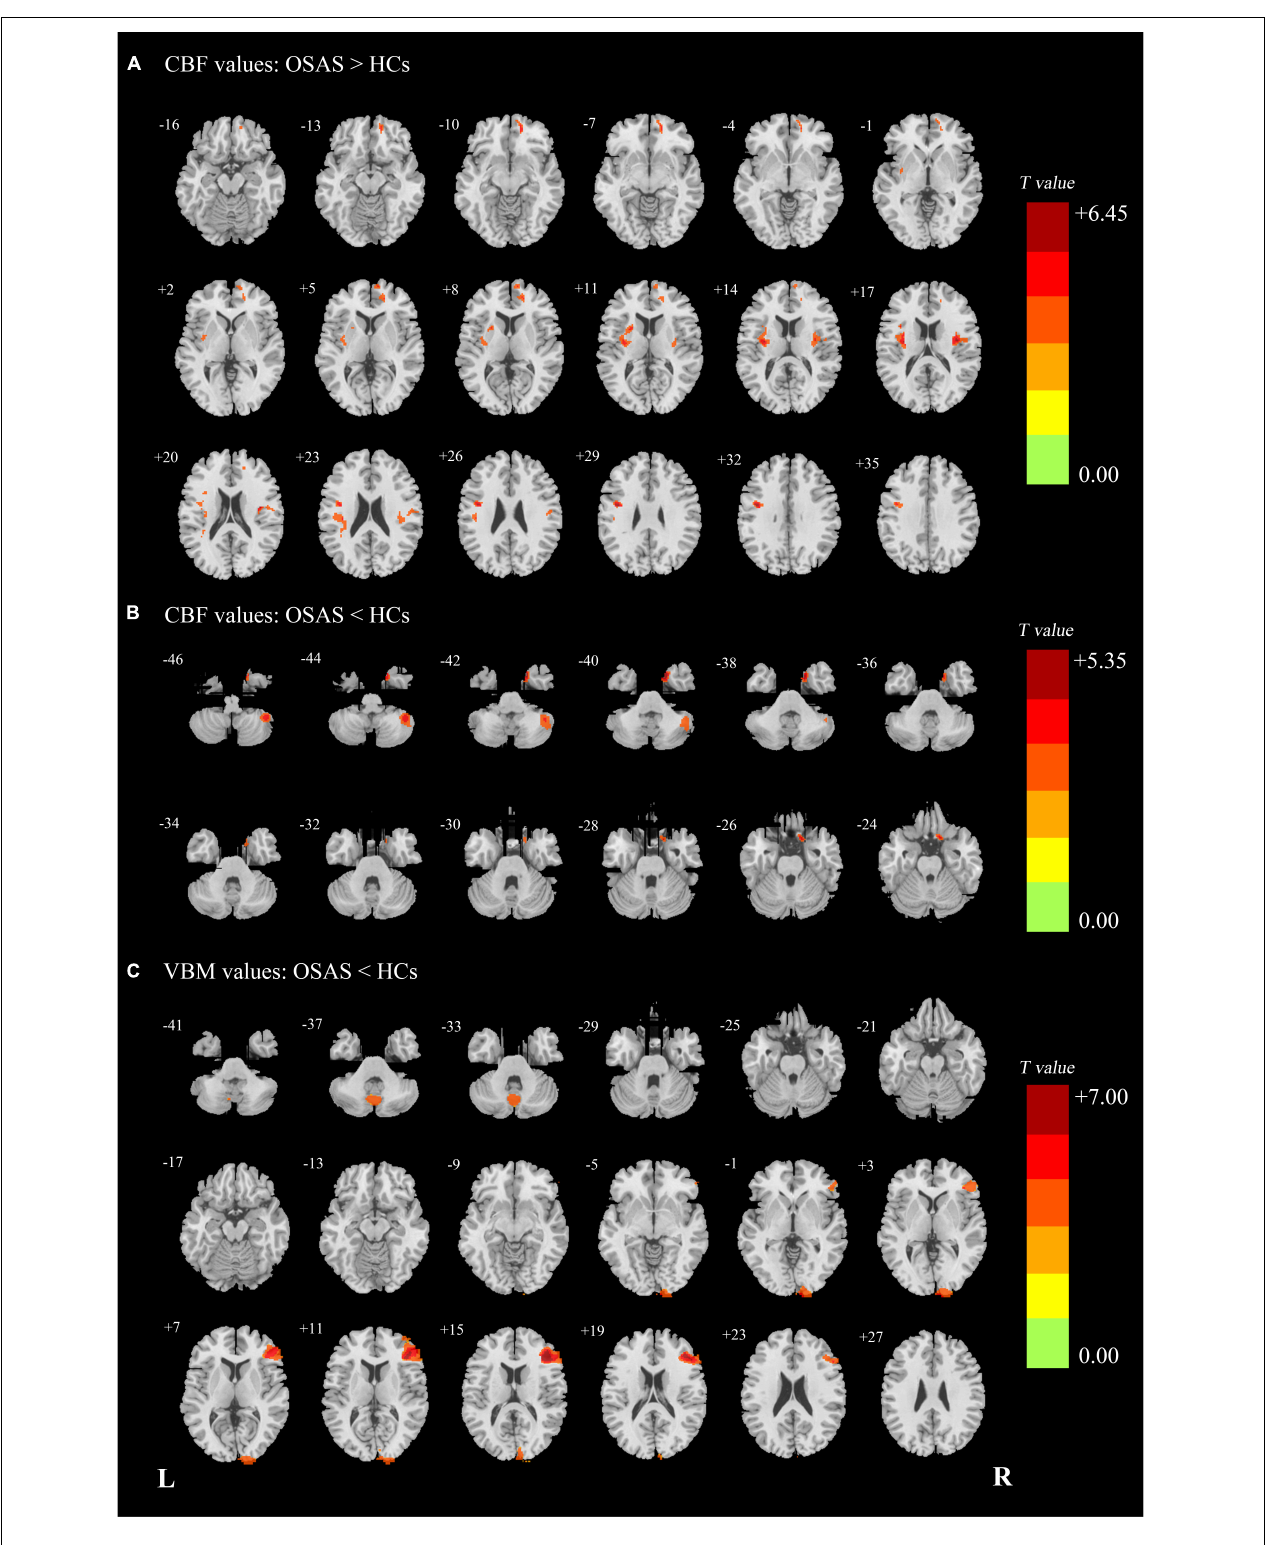
FIGURE 1 | (A) Patients with OSA showed significantly increased CBF clusters than HCs. (B) Patients with OSA showed significantly decreased cerebral CBF clusters than HCs. (C) Patients with OSA showed significantly decreased VBM clusters than HCs. OSA, obstructive sleep apnea syndrome; HCs, healthy controls; CBF, cerebral blood flow; VBM, voxel-based morphometry; L (R), left (right) hemisphere.